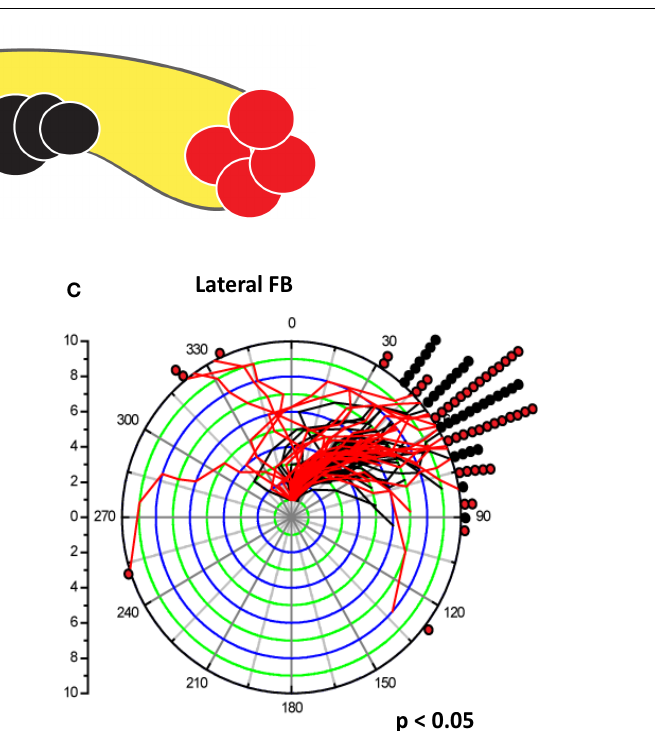
Curves that move to the left would be cases where the insect turned into the wall. Any lines moving from the origin to the 0 angle would indicate no turn at all (no trials in these cases).The pre-lesion traces (black) were plotted under the post-lesion (red) curves.The final position data were divided into 10˚ bins. Black and red dots were used to mark the frequency of each final position. All pre-lesion trials turned in the expected direction. (B) All post-lesion curves for medial FB lesion were similar to pre-lesion curves. In contrast, post-lesion traces (red) in individuals with lesions in the lateral FB (C) showed increased variability after the lesion with several turns into the wall or turns that start in the wrong direction well before correcting later in to the trial. Data from Harley and Ritzmann